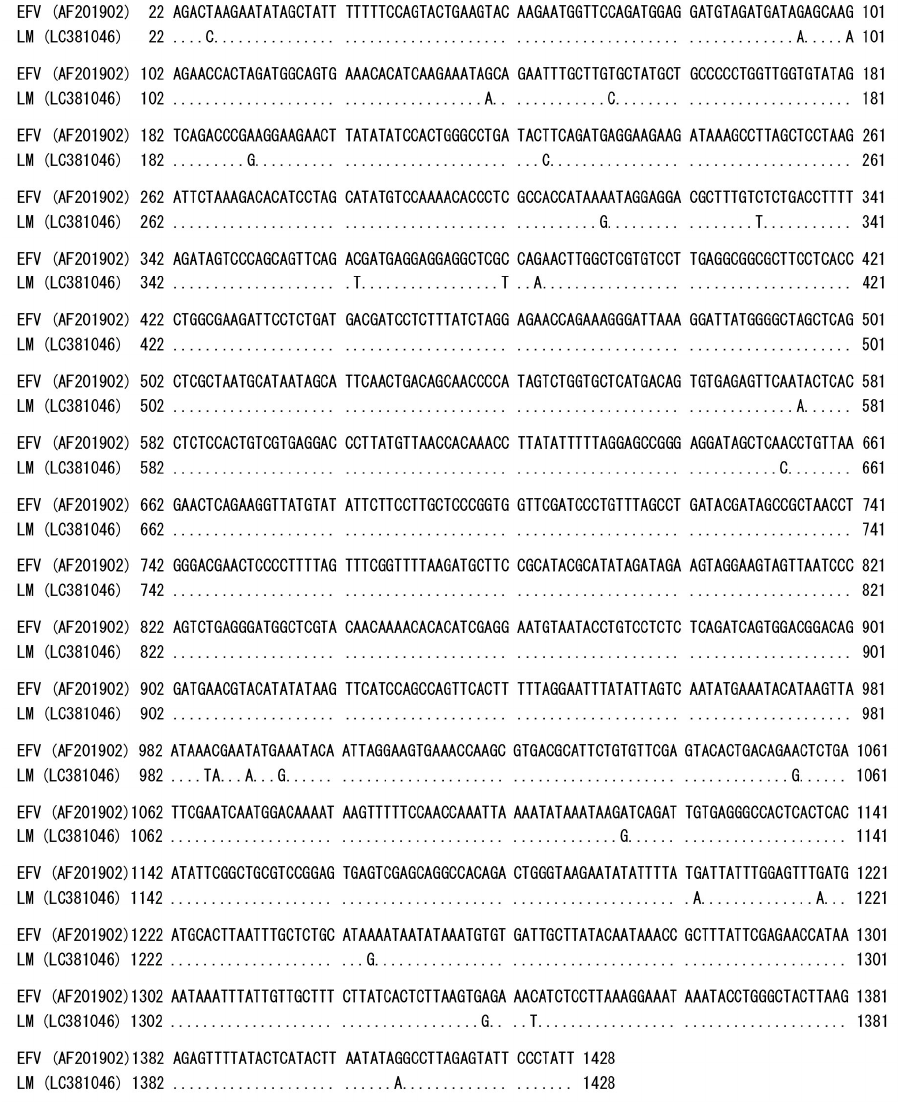
Figure 1. Comparison of the nucleotide sequences of LTR regions in the Japanese isolate EFVeca_LM and reference EFV. Identical nucleotides are indicated by dots. Numbers on the left and right sides are the nucleotide positions of EFV complete genome sequence (AF201902).